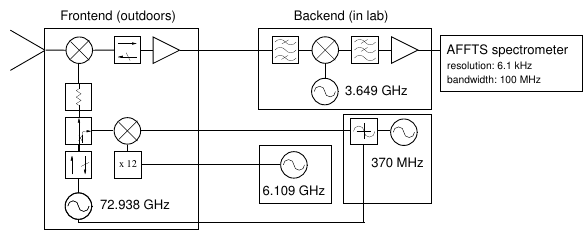
Fig. 5. Block diagram of WIRA’s receiver electronics.